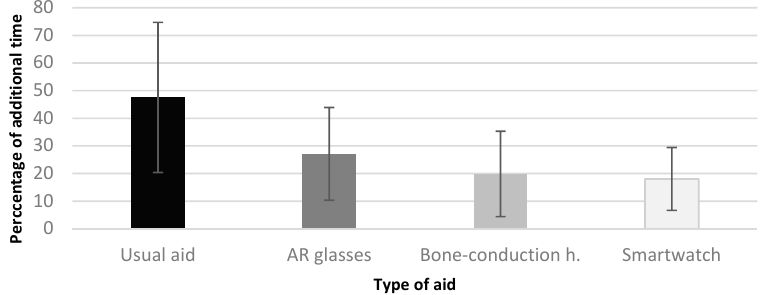
Figure 7. Percentage of additional time needed to navigate the route in comparison with the time computed by Google Maps. Vertical bars represent standard deviations.